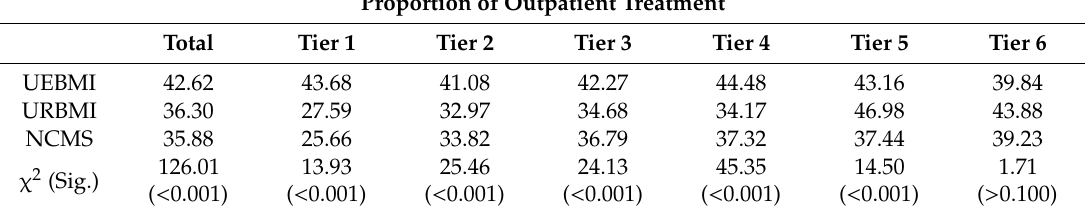
Table 2. Outpatient service utilization of the agricultural migrants with di ff erent types of health insurances